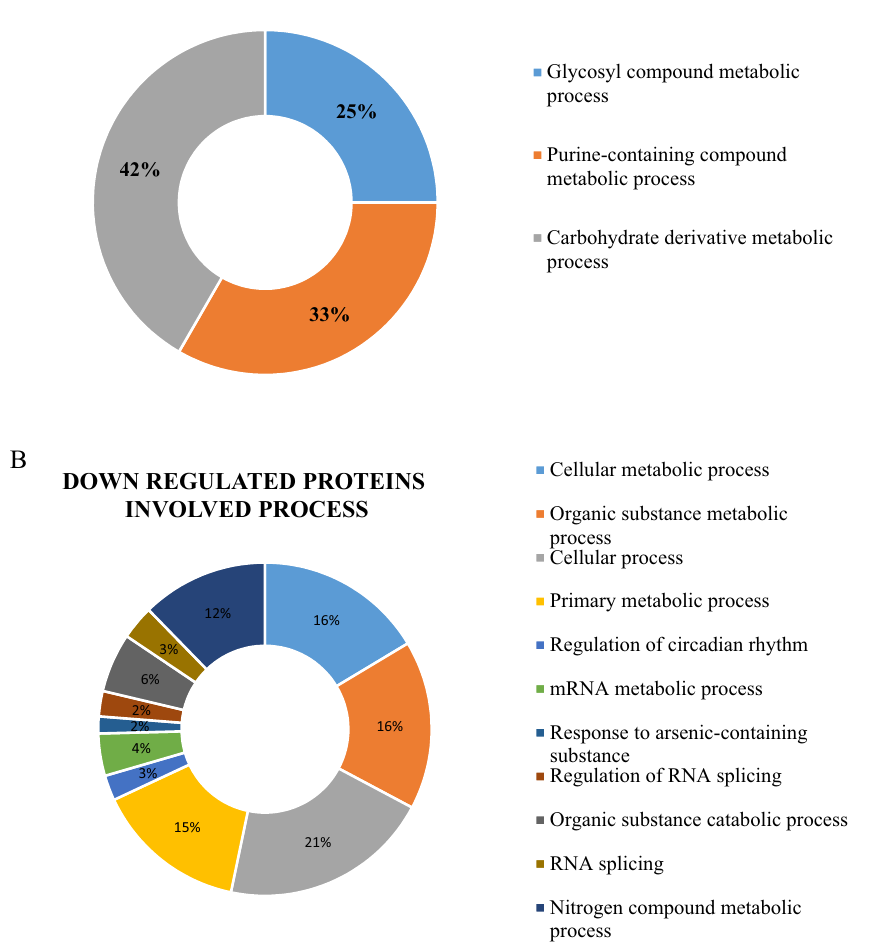
Figure 4. GO terms of up and down regulating process of HEF versus LEF groups. ( A ) A pie chart of upregulated peptides involved process; ( B ) A pie chart of down regulated peptides involved